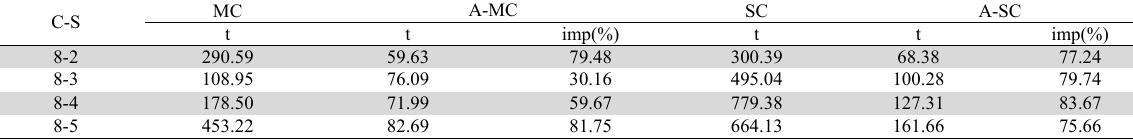
CPU time on the MCIRPSD with decomposition